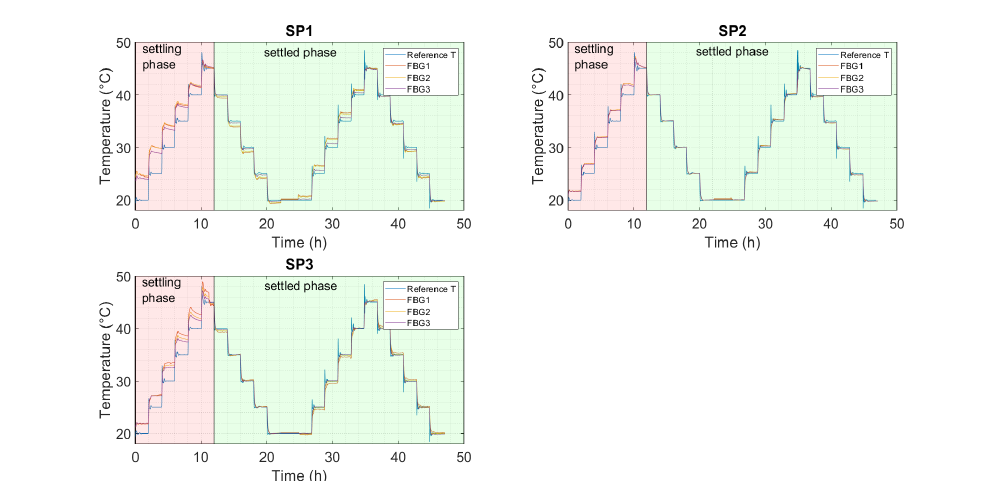
Figure 8. Temperature calculation using the polynomial fit from Figure 7/Table A3 for each FBG of each sensor encapsulation in the electrolyte. SP1: optical fiber in PEEK capillary, single-point mounting; SP2: optical fiber in fused silica tube with polyimide coating, single-point mounting; SP3: optical fiber in fused silica tube, removed polyimide coating, single-point mounting; SP4: optical fiber in fused silica tube, removed polyimide coating, double-point